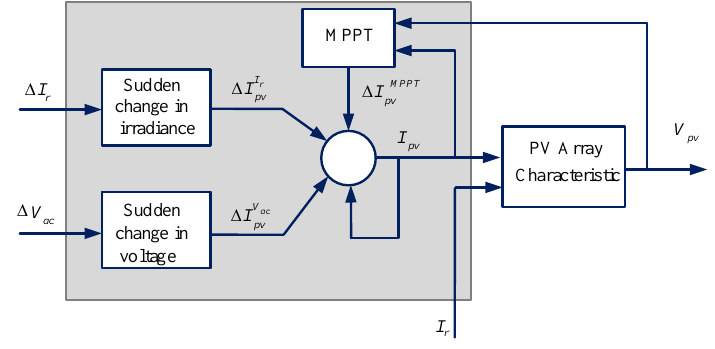
Figure 4. A generic method for PV generation.